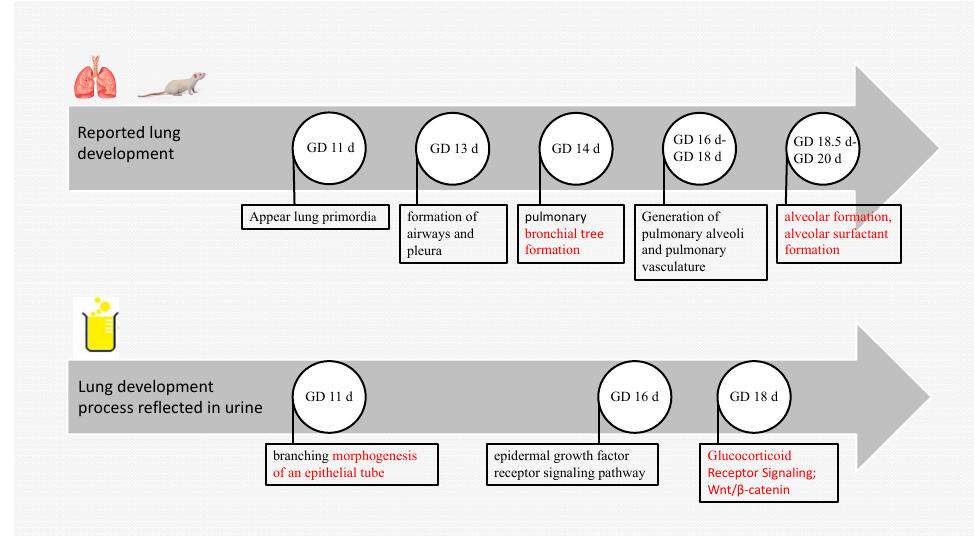
Figure 6. Fetal rat lung development. The above is the reported lung development process. The following are lung developmental processes enriched by changing urinary proteomes.